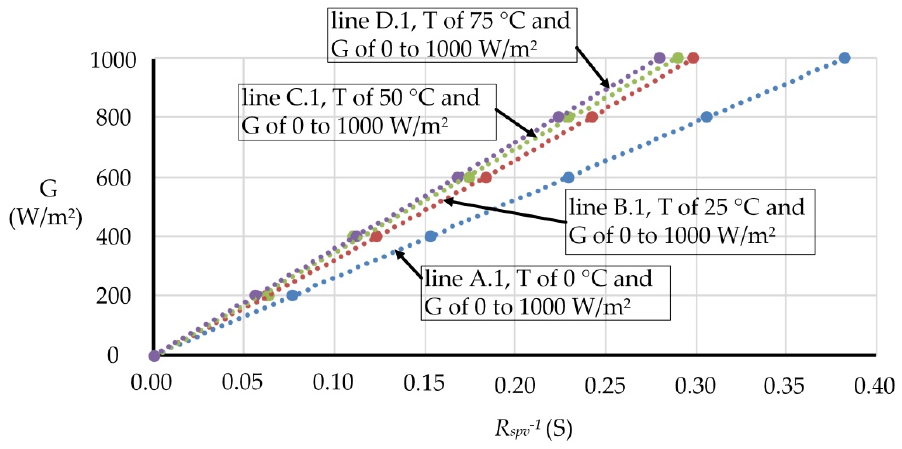
Figure 3. Relationship between R spv − 1 and the irradiance level.